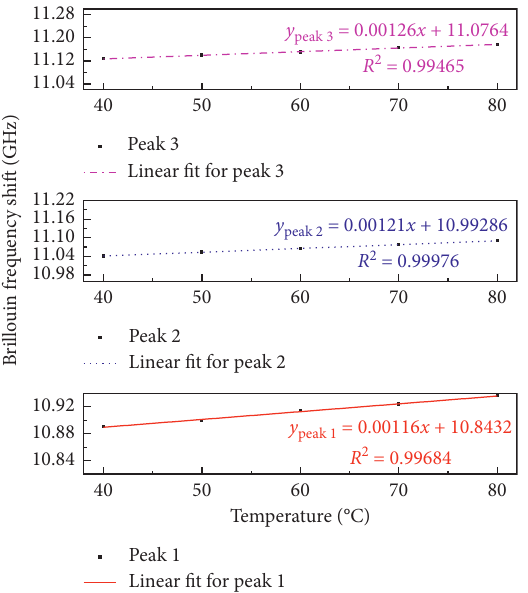
Figure 4: Measured BFS as a function of temperature for peak 1, peak 2, and peak 3,